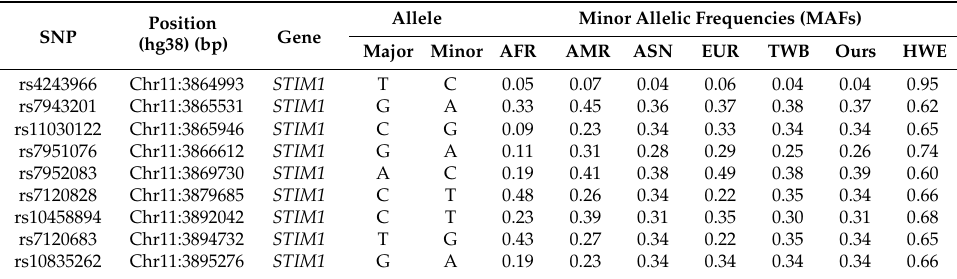
Table 2. Minor allelic frequencies of single-nucleotide polymorphisms (SNPs) in this study. Allele Minor Allelic Frequencies Position SNP (hg38) (bp) Gene